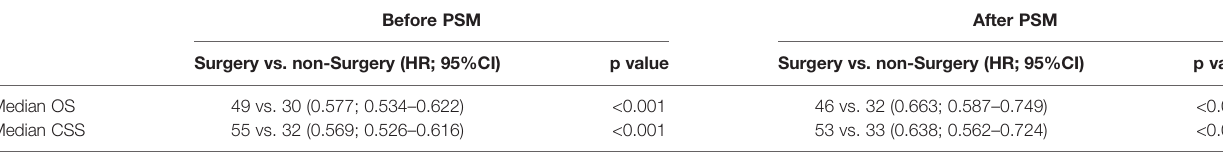
TABLE 3 | Comparison of median survival time between the two groups of patients. Before PSM After PSM Surgery vs. non-Surgery (HR; 95%CI) Surgery vs. non-Surgery (HR; 95%CI)